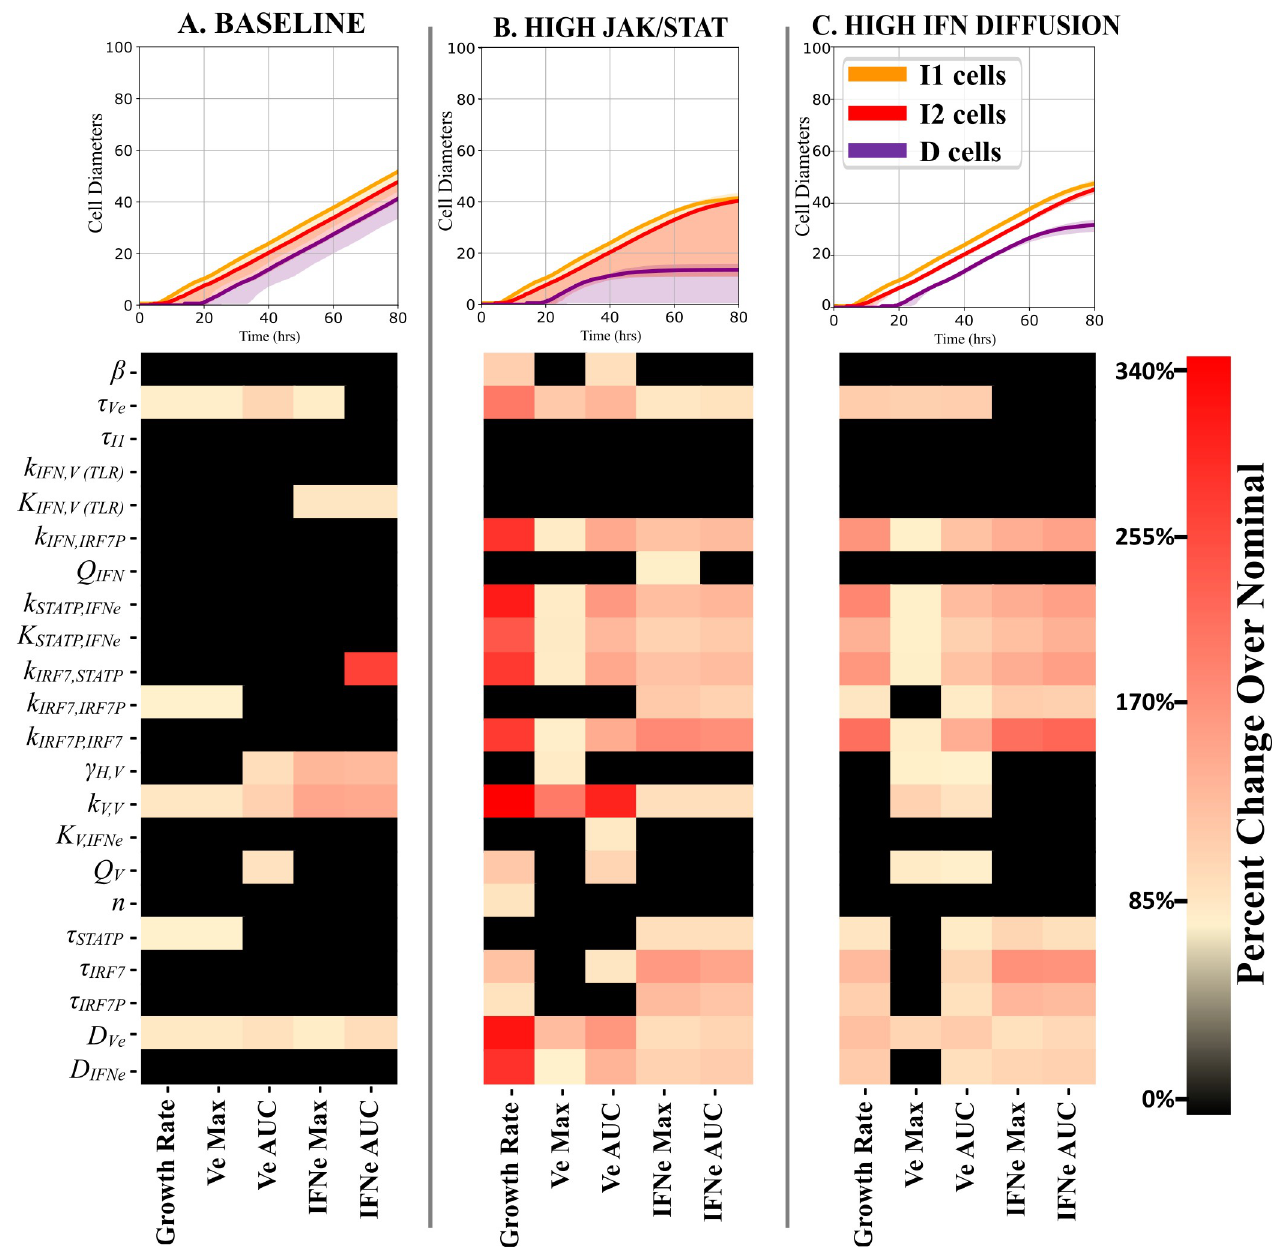
Fig 9. Local single-factor sensitivity analysis for three simulation regimes. (A) “Baseline” corresponds to the baseline parameters in Table 2. (B) “High JAK/ STAT” corresponds to a 15x increase in the phosphorylation rate of STATP via the JAK/STAT pathway (parameter k STATP , IFNe ), with all other parameters as in Table 2. (C) “High IFN Diffusion” corresponds to a 10x increase in the diffusion coefficient of IFN e , with all other parameters as in Table 2. Sensitivity analyses varied each parameter one-at-a-time ± 25% around its unperturbed value and quantified the average plaque radius growth rate at the end of the simulation, the maximum extracellular virus (V e ) and interferon (IFN e ) levels that occurred, and the area under the curve (AUC) for both average V e and IFN e . The sensitivity metrics average the absolute values of the metric for increased and decreased parameters over 20 replicas for each parameter set.